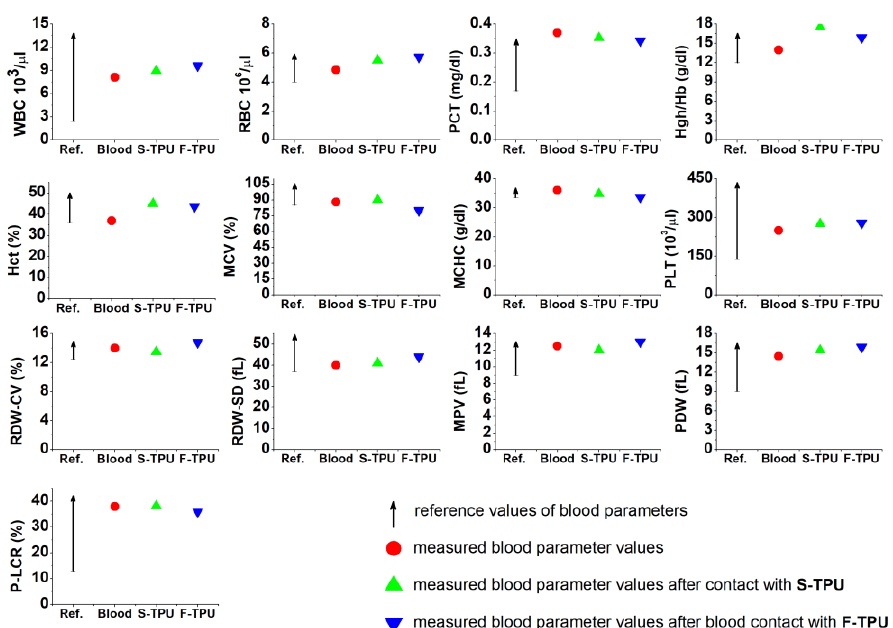
Figure 6. Short-term biocompatibility of S-TPU and extruded F-TPU filament with human blood. WBC—white blood cells (leucocytes); RBC—red blood cells (erythrocytes); PCT—percentage of platelets in whole blood volume; Hgh/Hb—hemoglobin; Hct—hematocrit; MCV mean corpuscular volume; MCHC—mean concentration of hemoglobin in blood cells; PLT—platelet amount (thrombocytes); RDW-CV/RDW-SD—distribution volume of red blood cells; MPV—mean platelet volume; PDW—indicator of platelet volume distribution; P-LCR—platelet larger cell ratio.